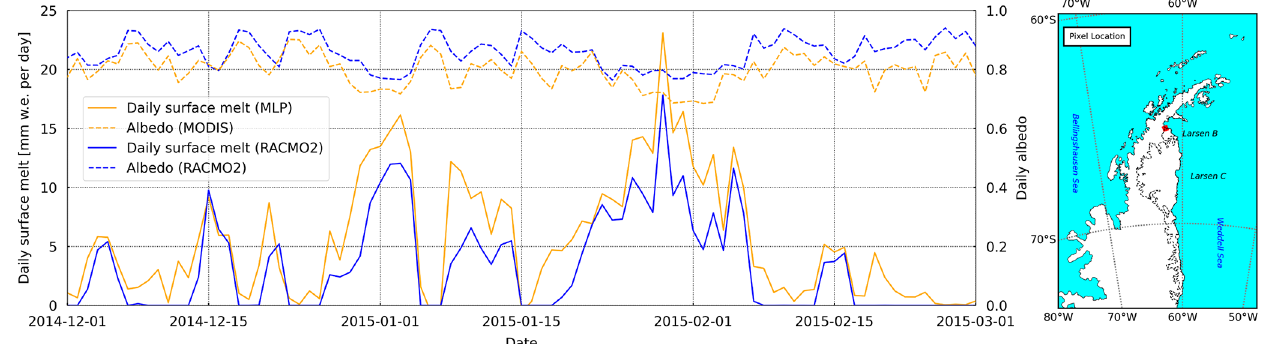
Figure 12. Daily surface melt from regional atmospheric climate model version 2.3p2 (RACMO2) simulations and multilayer percep- tron (MLP) estimations, albedo from RACMO2 and MODIS at the additional test site in the north of AWS 17 (left panel), and the geolocation of the test site (i.e., the red square in the right panel). The shapefiles of the Antarctic coastline and ice shelves are provided by the Scientific Committee on Antarctic Research Antarctic Digital Database (SCAR ADD; https://www.add.scar.org/, last access: 11 November